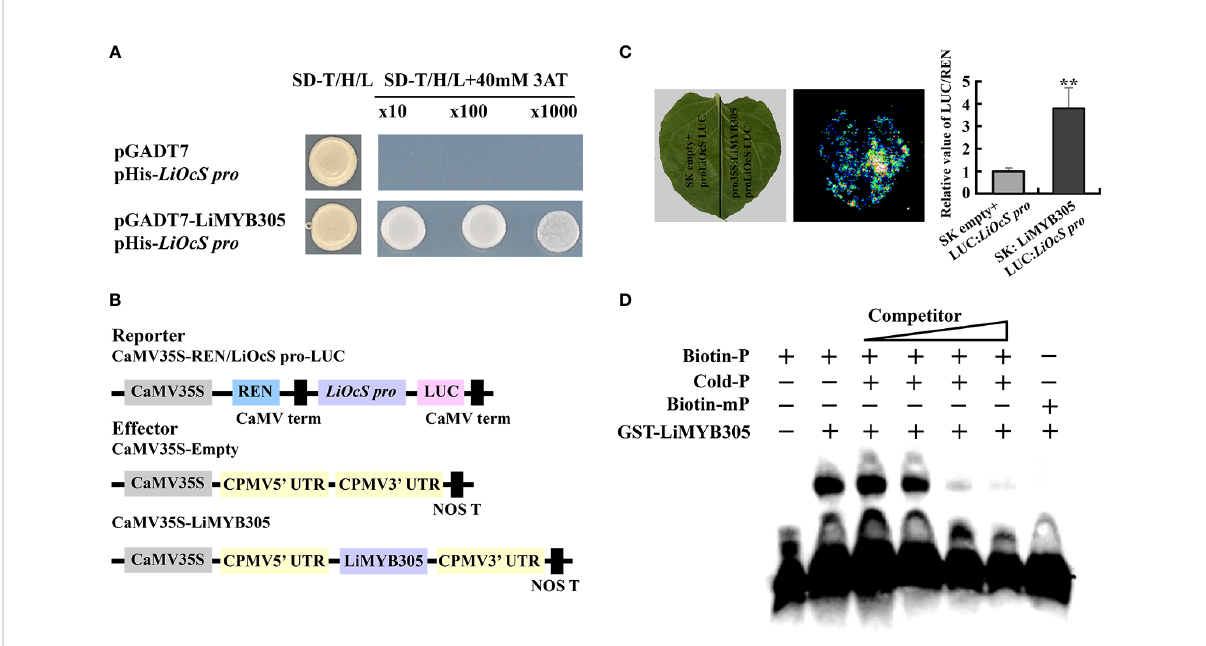
FIGURE 6 Interaction between LiMYB305 and the LiOcS promoter. (A) Analysis of LiMYB305 binding to the LiOcS promoter in the yeast one-hybrid system. The empty prey vector (AD) was used as the negative control. (B) Schematic representation of the constructed dual LUC reporter system. (C) Live imaging (left) and quantitative analysis (right) of transcriptional repression of the LiOcS promoter by LiMYB305. The LUC : LiOcS pro construct was co-in fi ltrated with SK : LiMYB305 or the SK empty vector in N. benthamiana leaves. Experiments were independently repeated three times. A representative image of an N. benthamiana leaf 3 days after in fi ltration is shown. Mean ± SD are shown from three replicates (n = 3). (D) EMSA of LiMYB305 binding to the LiOcS promoter. ** P <